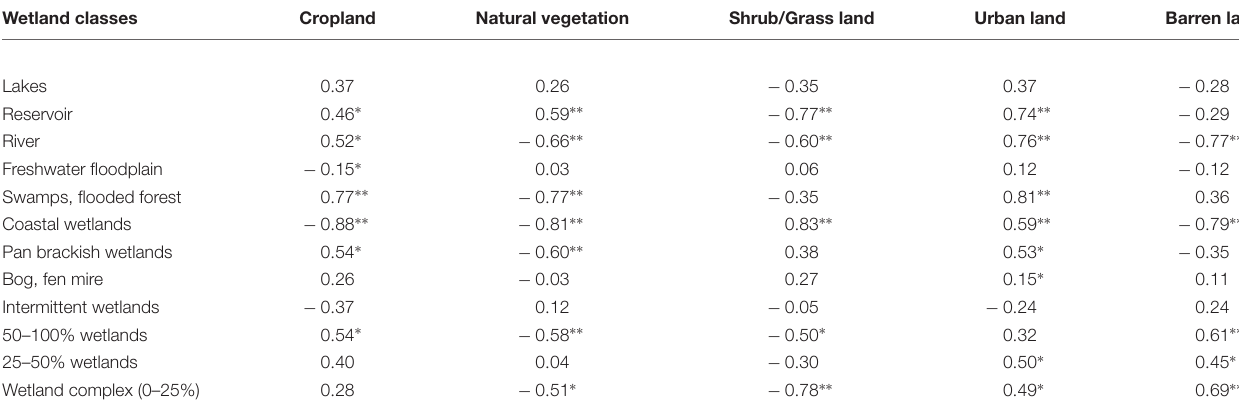
TABLE 3 | Correlation matrix for anthropogenic drivers and global lakes and wetlands (1995–2015). Wetland